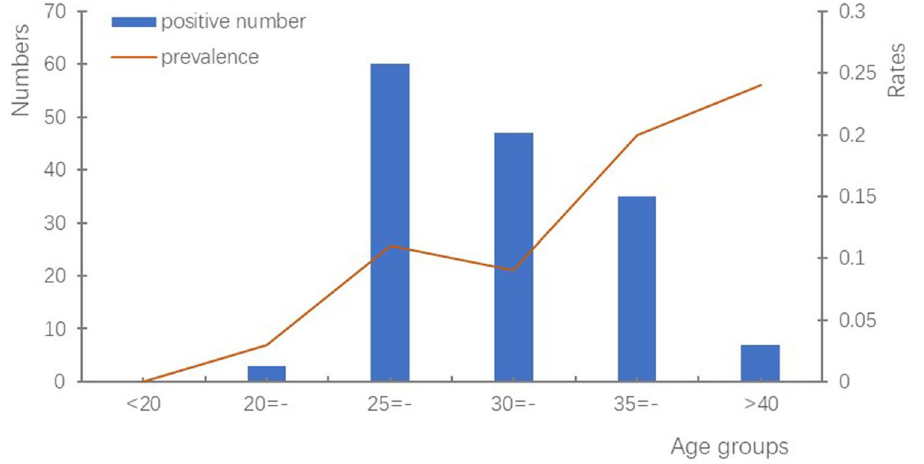
Figure 2. Trend of HCV prevalence with age in four